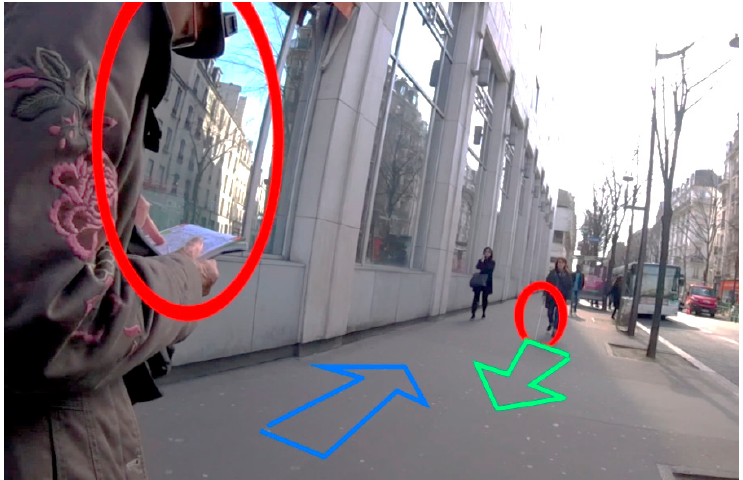
Figure 10. The participant was reading her map while walking and could not avoid the collision with a blind person approaching from